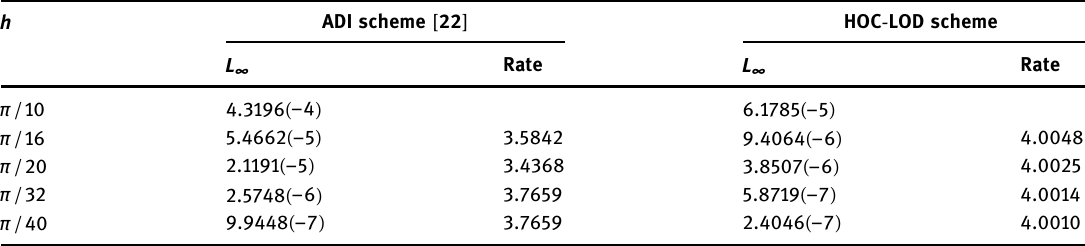
Table 5: L ∞ error and rate when = T 1 and = τ 0.0025 for various h for Example 2 h